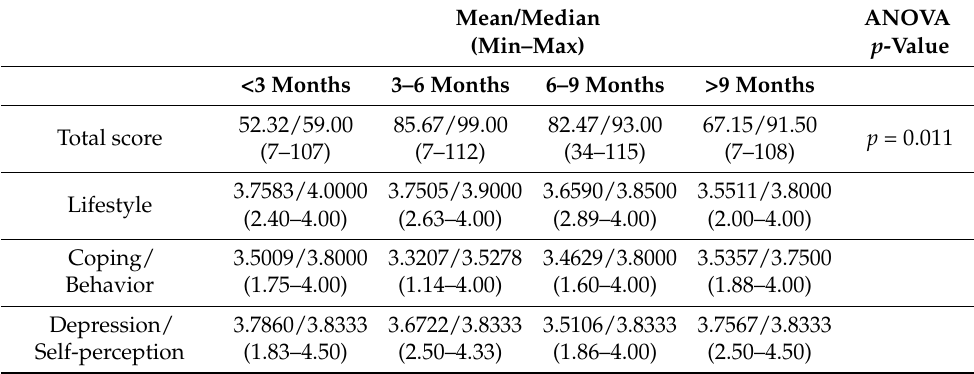
Table 5. Fecal Incontinence Quality of Life Scale